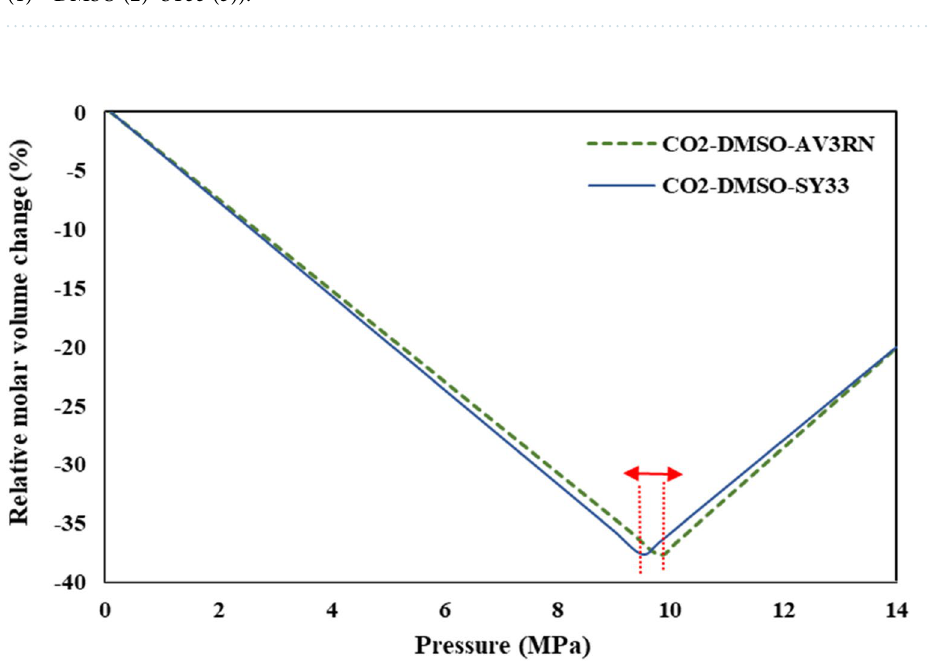
Figure 6. Relative molar volume change of the liquid phase vs. pressure, for the ternary systems (CO 2 –DMSO– AV3RN) and (CO 2 –DMSO– SY33) at 328